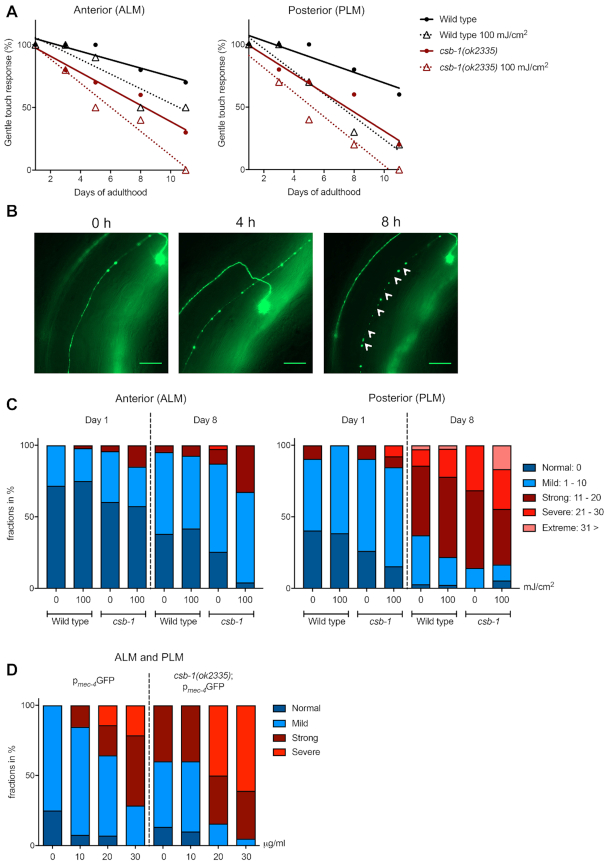
Loss of neuronal integrity is accentuated in csb-1 mutants. (A) Gentle touch response assayed in the anterior part of the animal (ALM neurons), or the posterior (PLM neurons), respectively. Animals were treated with UVB at young adult stage, and measured on the Day of UV radiation (Day 1), and on the Days 3, 5, 8 and 11 thereafter. Plot shows nonlinear regression (curve fit) line. (B) Representative images of neuronal beading in a time-dependent manner in animals expressing pmec-4GFP. Gentle touch mechanosensory neurons were irradiated at Day 1 of adulthood and neuronal beading was observed for morphological changes at Day 8 (time: 0) after treatment. The first timepoint shows a neuron with beading. With time, the beading becomes more severe, until it reaches a stage with breakages along the axon resulting in degeneration, which is indicated by white arrows. Scale bars are 25 μm. (C) Quantification of degeneration in anterior (ALM) and posterior (PLM) mechanosensory neurons. Animals were treated at young adult stage, and measured on the Day of treatment (Day 1) and 7 Days after (Day 8). Degeneration is measured by quantifying the severity of beading per animal. Statistical analysis is available in Supplementary Table S3. (D) Quantification of neuronal beading along ALM and PLM axons in animals 24 h post-treatment with different concentrations of Illudin M.